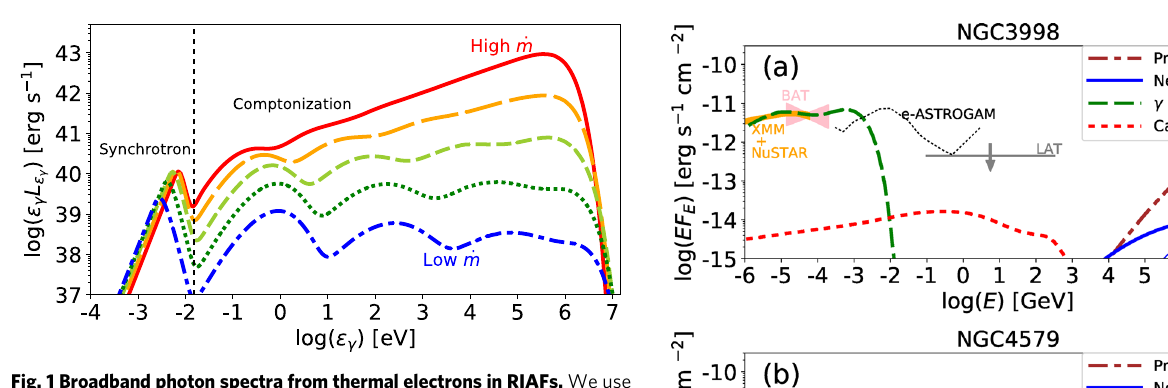
Fig. 1 Broadband photon spectra from thermal electrons in RIAFs. We use the parameter set for model A (reference model) with M = 10 8 M ⊙ and various _ m . The solid, long-dashed, short-dashed, dotted, and dotted-dashed lines are for _ m ¼ 0 : 03 ; 1 : 1 ´ 10 (cid:3) 2 ; 3 : 7 ´ 10 (cid:3) 3 ; 1 : 3 ´ 10 (cid:3) 3 ; 4 : 6 ´ 10 (cid:3) 4 , respectively. The photons of energies below the vertical dotted line are mainly emitted by the synchrotron process, while the photons above the energy are produced by the Comptonization process.